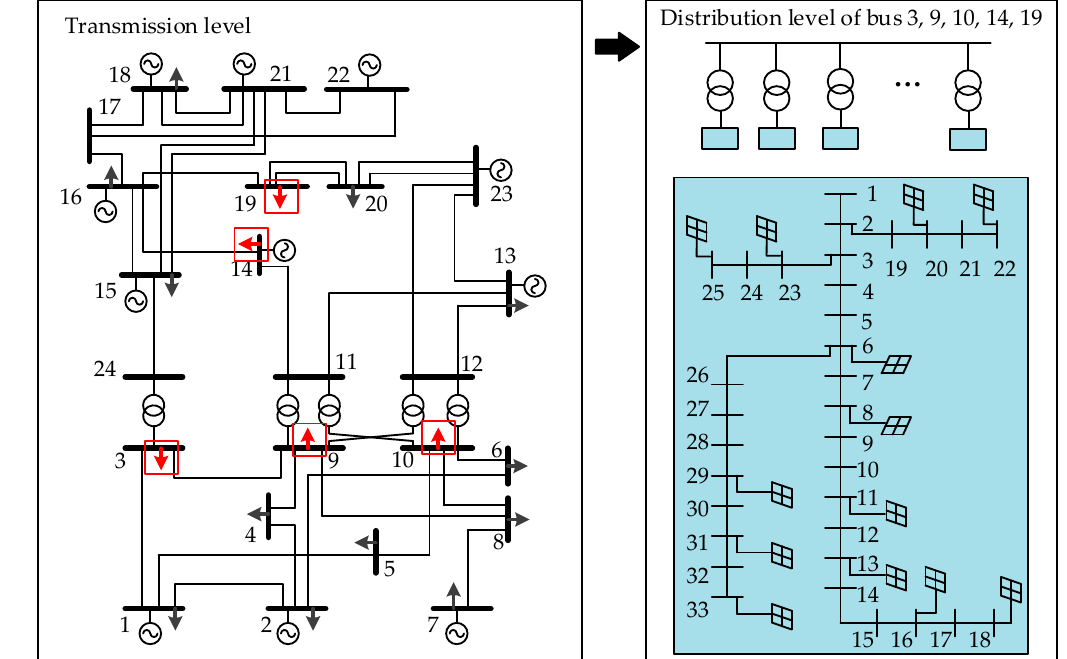
Figure 5. The integrated transmission–distribution system. Table 1. Modified 33-bus system branch parameter (p.u.).